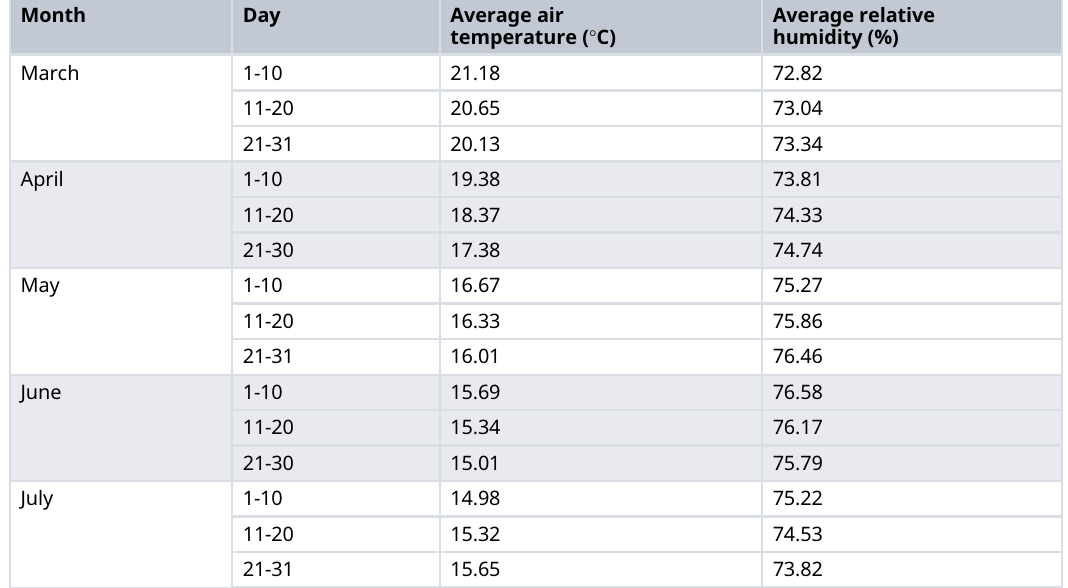
Table 4. Air temperature and relative humidity in 2020